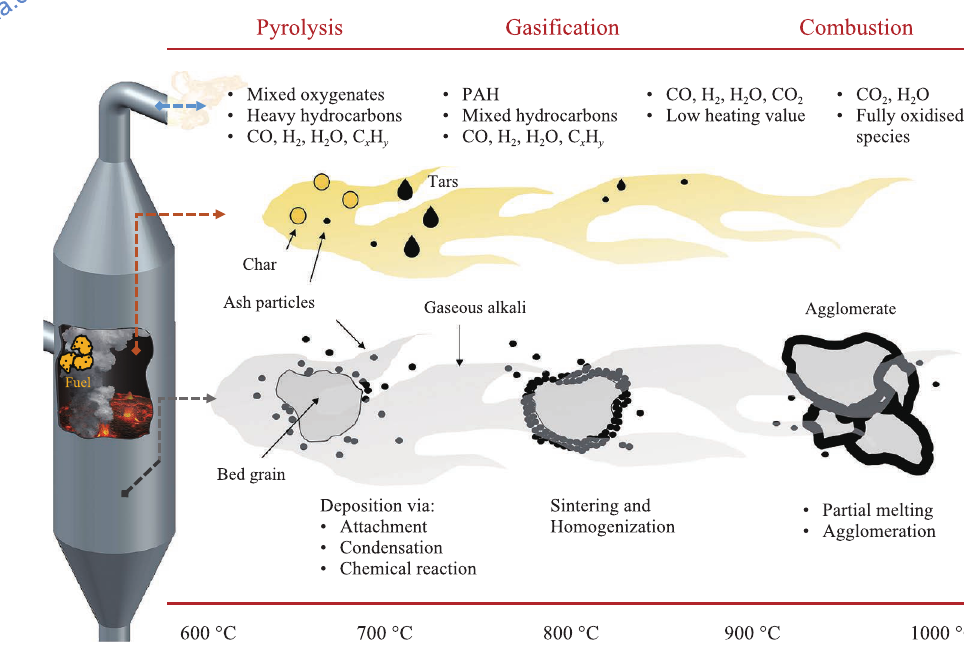
Fig. 1 Fuel transformation scheme and influence of temperature and oxidation stage in an FBR.